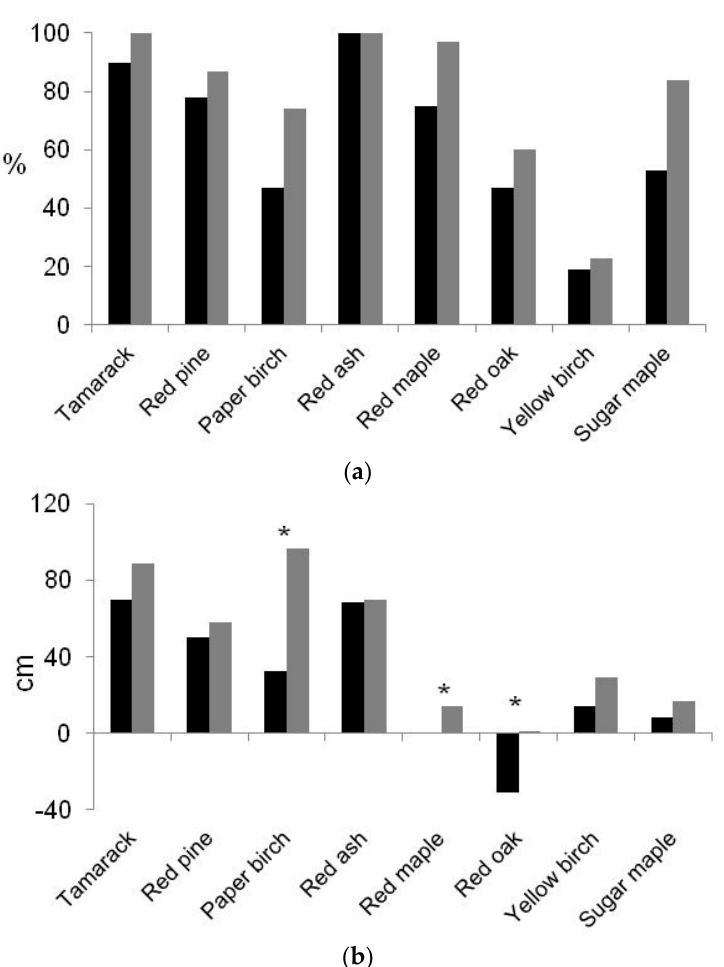
Figure 3. Differences of ( a ) survival rates in spring 2015 and ( b ) height growth increment (2010–2015) for seedlings growing in herbaceous vegetation. Black bars: seedlings unprotected against small mammal predation. Grey bars: seedlings protected. (* p < 0.05, two-sample t -test).